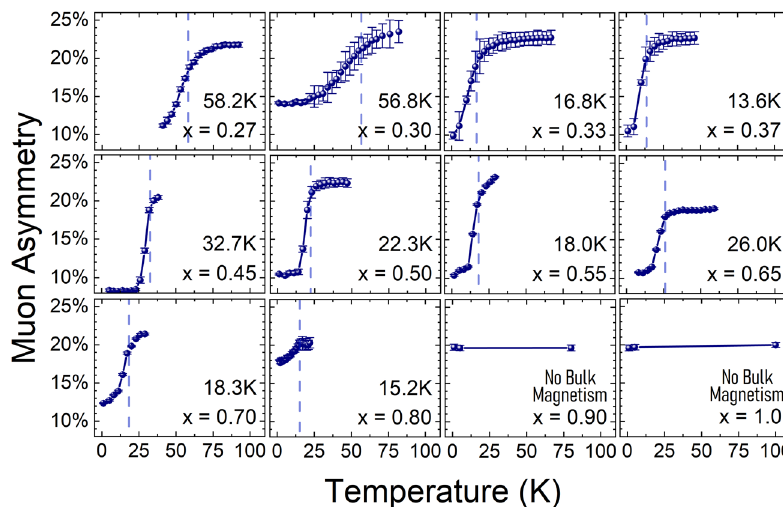
Fig. 2 Results of fi ts to muon spin relaxation ( µ SR) data collected on EMU. Summation of re fi ned asymmetry amplitude with each blue circle representing the value of the longitudinal relaxation, G z ð t Þ , modeled as a stretched exponential of the form G z t ð Þ ¼ A 0 þ A 1 e (cid:2) λ t ð Þ β at t = 0 s for the given temperature. A 0 , A 1 , λ , and β are all constants to model the exponential decay of the detected asymmetry (the difference in positrons produced in muon decay between the front and back detectors) as a function of time, t . The vertical dashed line represents magnetic transition temperatures de fi ned by the in fl ection point in the 2 nd derivative of the magnetization curve. Constant asymmetry values above 20% are expected for non-magnetic samples. When asymmetry drops to ~8-12%, a sample is exhibiting bulk magnetism 70,71 . The error bars are reported from the asymmetry amplitude fi t performed using the Mantidplot software 67